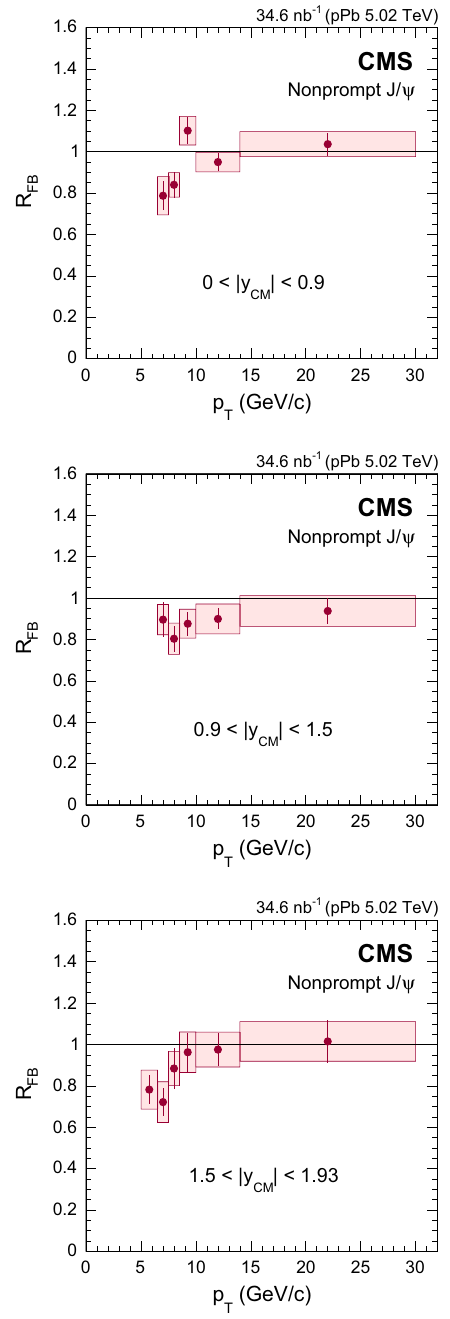
Fig. 12 Transversemomentumdependenceof R FB fornonpromptJ /ψ mesons in three y CM regions. The vertical bars represent the statistical uncertainties and the shaded boxes show the systematic uncertainties new constraints on cold nuclear matter effects on prompt and nonprompt J /ψ production over a wide kinematic